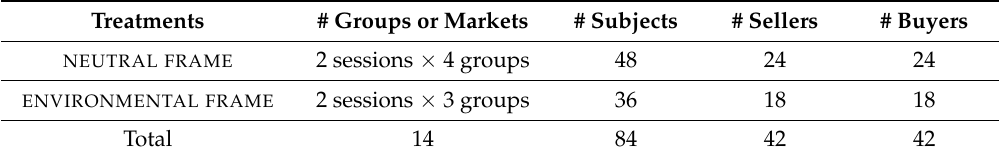
Table 3. Sessions